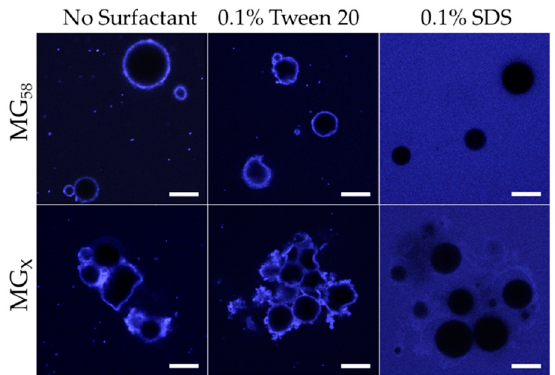
Figure 6. Confocal micrographs of MG 58 or MG X emulsions in the presence of Tween 20 and SDS surfactants; scale bars = 20 μ m.